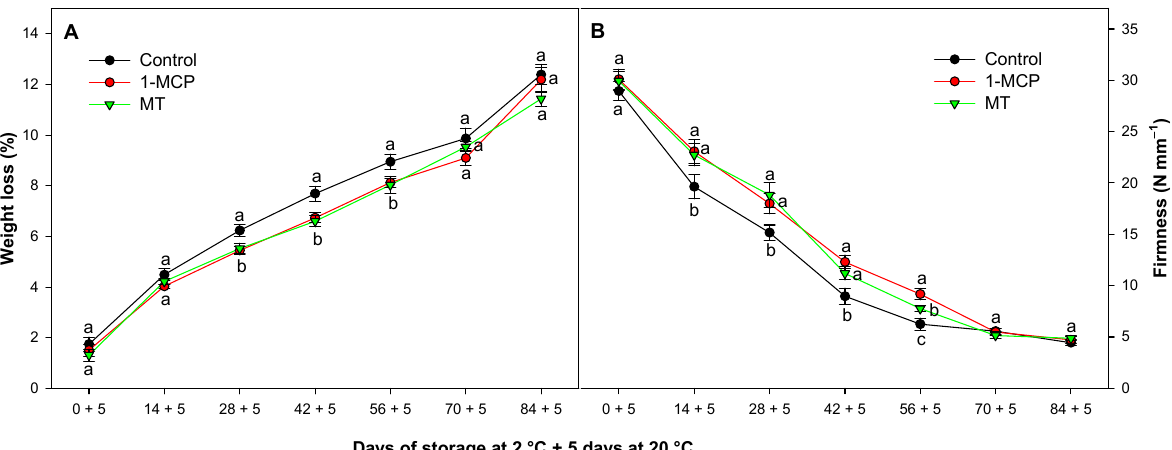
Figure 1. Evolution of weight losses ( % ) ( A ), and fruit firmness (N mm − 1 ) ( B ) of ‘Hayward’ kiwifruit treated with distilled water (Control), 1-MCP at 0.5 µL L − 1 or melatonin at 0.1 mM (MT) during cold storage plus 5 days at 20 °C. Data are the mean ± SE ( n = 3). Different lowercase letters show significant differences ( p < 0.05) among treatments for each sampling date.